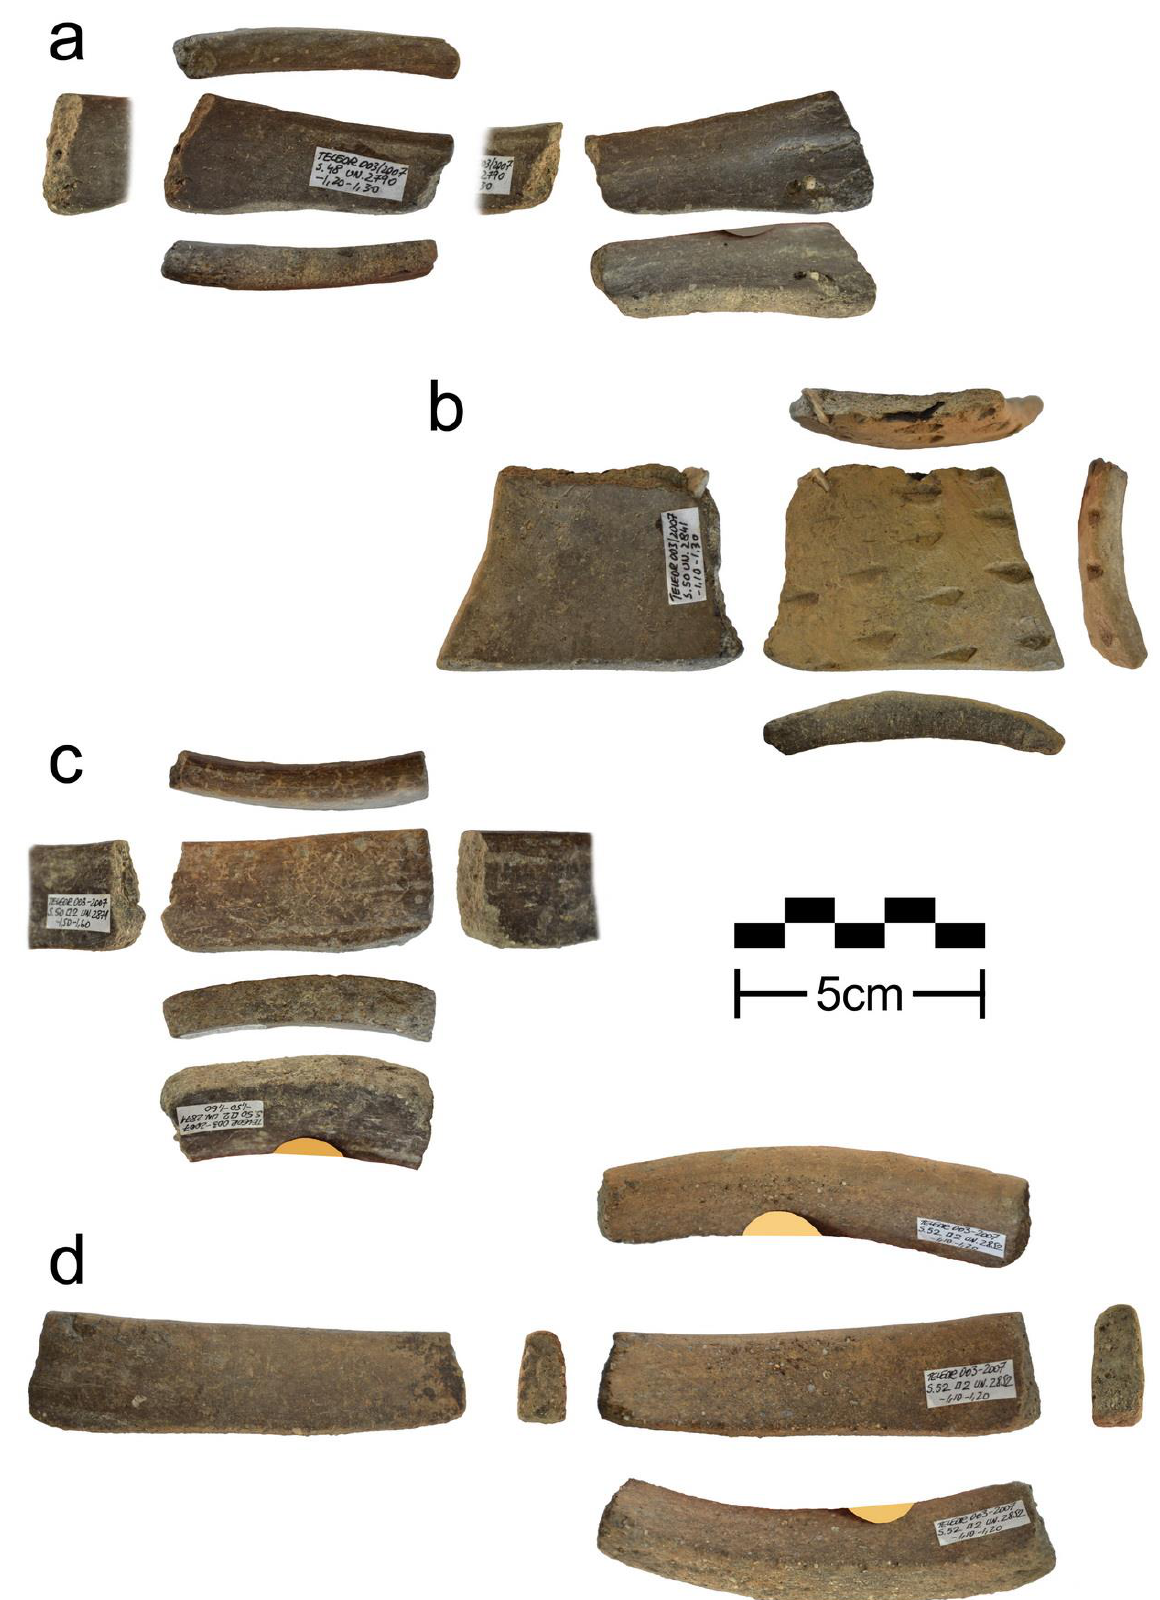
Figure 11. Examples of re-used ceramic sherd smoothers from Măgura